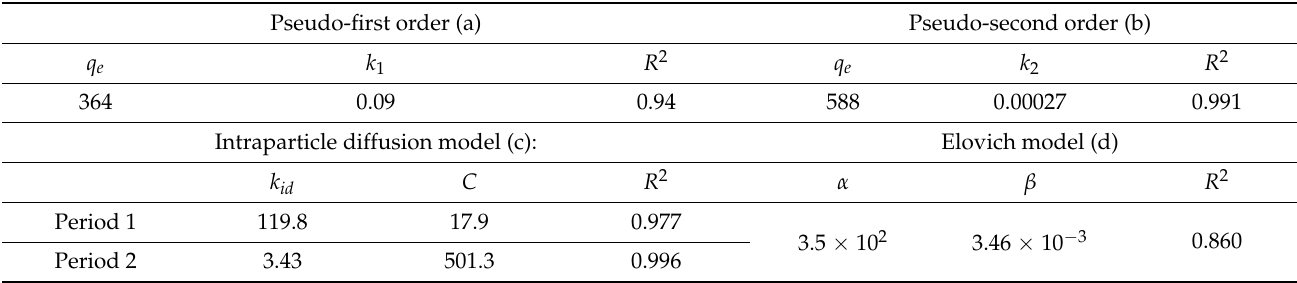
Table 3. Parameters of the sorption kinetics of lead